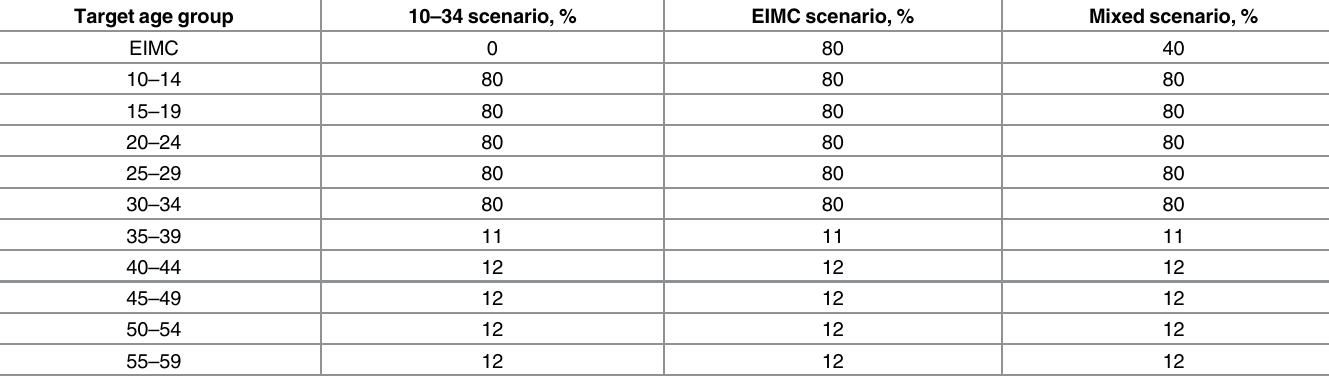
Table 2. Scenarios Used to Examine the Impact, Cost, and Cost-effectiveness of Three Strategies. Target age